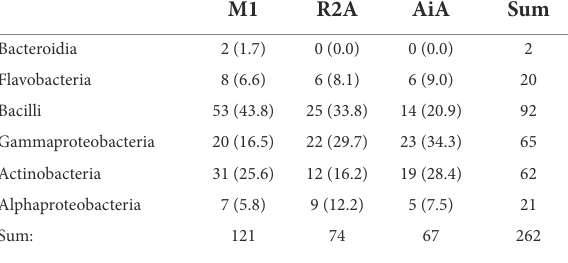
TABLE 2 Taxonomic composition of the isolates grouped among the tree isolation media, given are the numbers of respective isolates and relative numbers of isolates for the respective media in